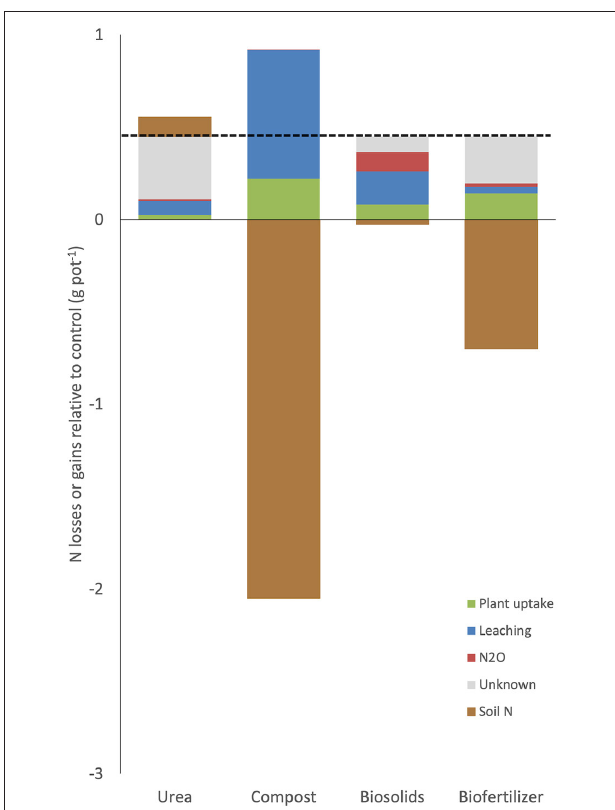
FIGURE 7 | A partial N mass balance illustrating the losses of added PAN from pots in the forms of plant N uptake (green), N 2 O–N emissions (red), and inorganic N leached (blue). Nitrogen mass loss from each of these pathways was determined as treatment minus control to account for plant and microbial use of N without amendments or fertilizer. Gray bars indicated unknown losses of N, which may include N 2 or other forms of reactive N. The black dotted line indicates the amount of PAN added to each pot. Brown bars represent. Brown bars represent treatment differences (treatment—control) in soil total N. Positive values indicate fluxes to the environment, whereas negative values indicate N sinks in the